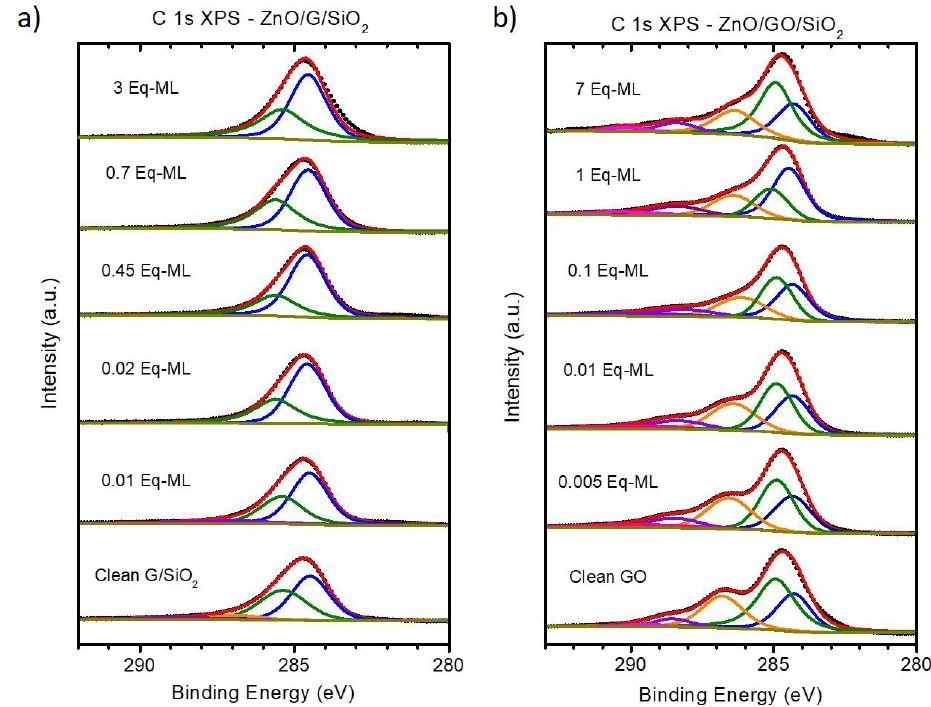
Figure 5. In-situ C 1s XPS spectra for ( a ) ZnO/G/SiO 2 and ( b ) ZnO/GO/SiO 2 for a selected set of deposition stages.